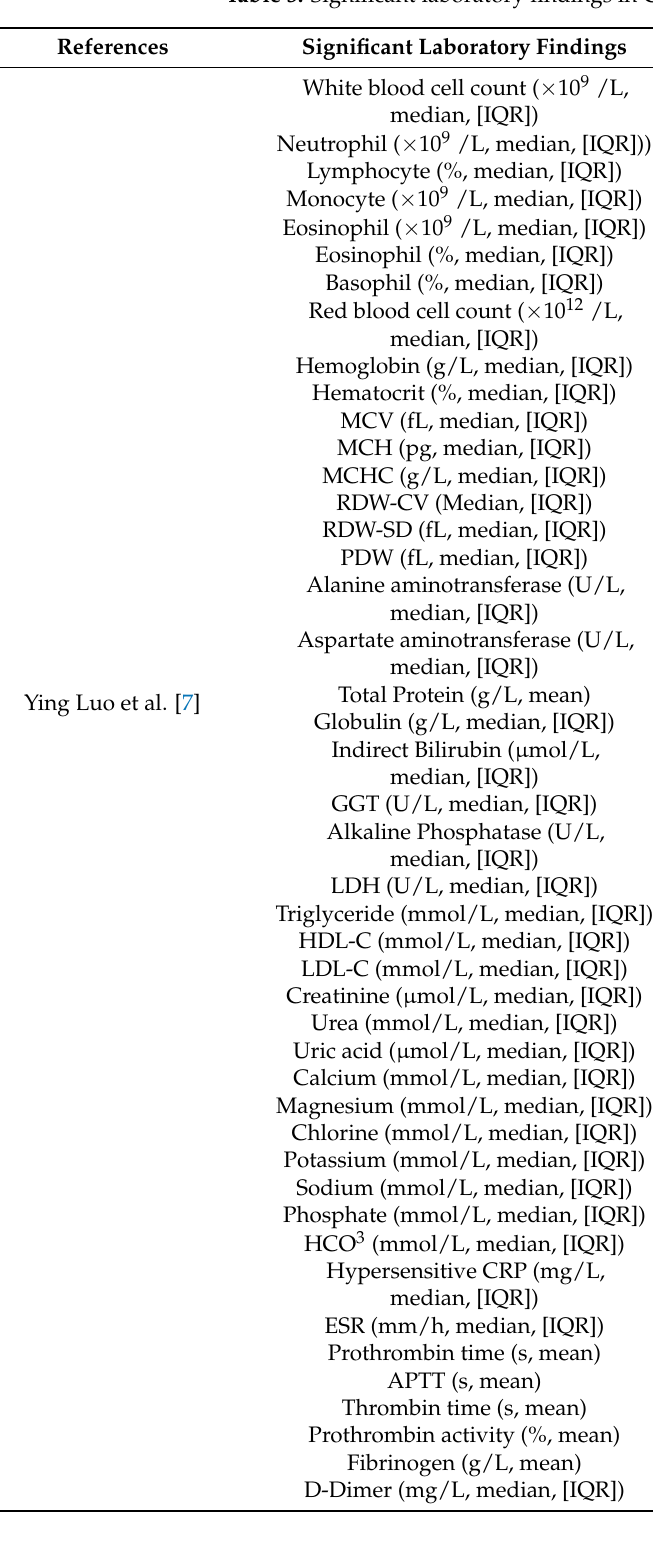
Table 3. Significant laboratory findings in COVID-19 and influenza adult